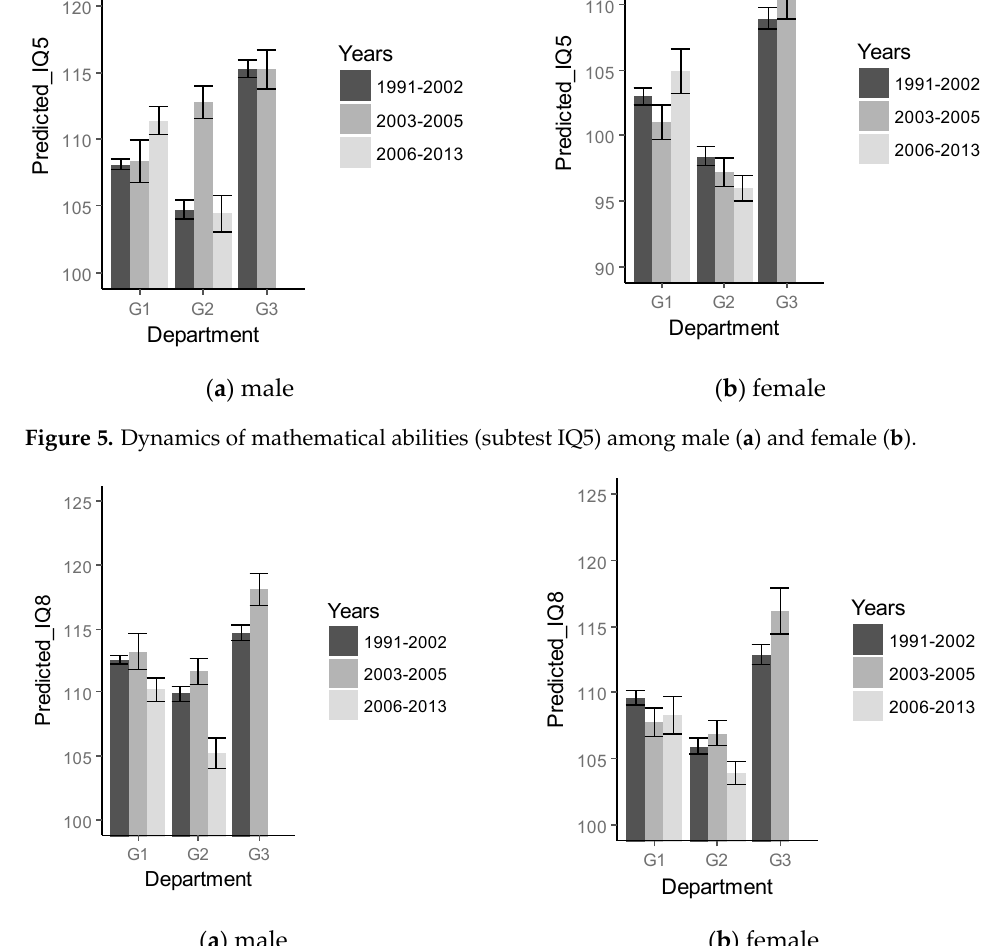
group is characterized by significantly greater differences in the structure of intelligence